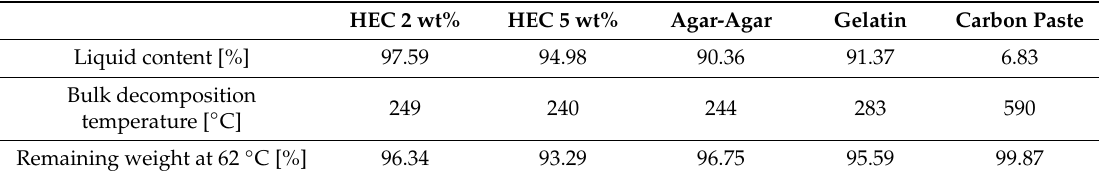
Table 3. Liquid content, bulk decomposition temperature and remaining weight at 62 ◦ C for the SVM samples.